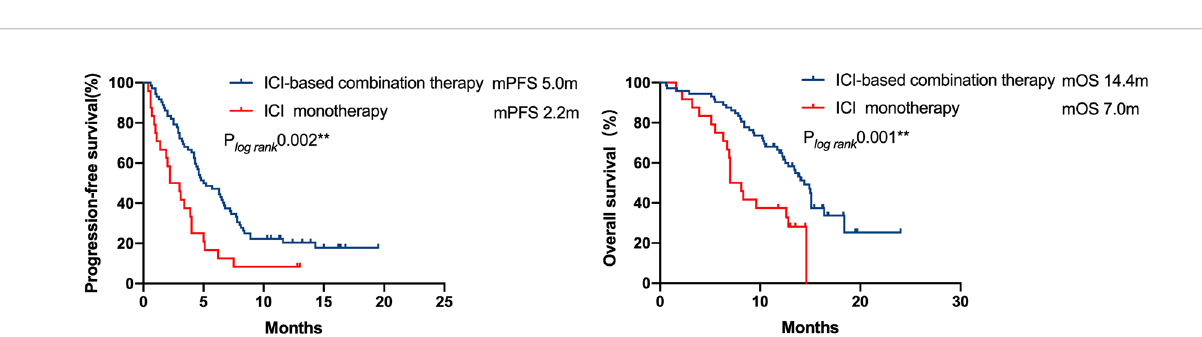
FIGURE 2 | Kaplan – Meier curves of progression-free survival and overall survival of patients who received ICI therapy at different lines of treatment. The patients who were administered front-line ICI exhibited superior survival bene fi ts than those who received ICI as later line after progression on TKI (mPFS 7.2 months vs. 3.4 months, respectively, P < 0.0001; mOS 15.1 months vs. 8.4 months, respectively, P < 0.0001).